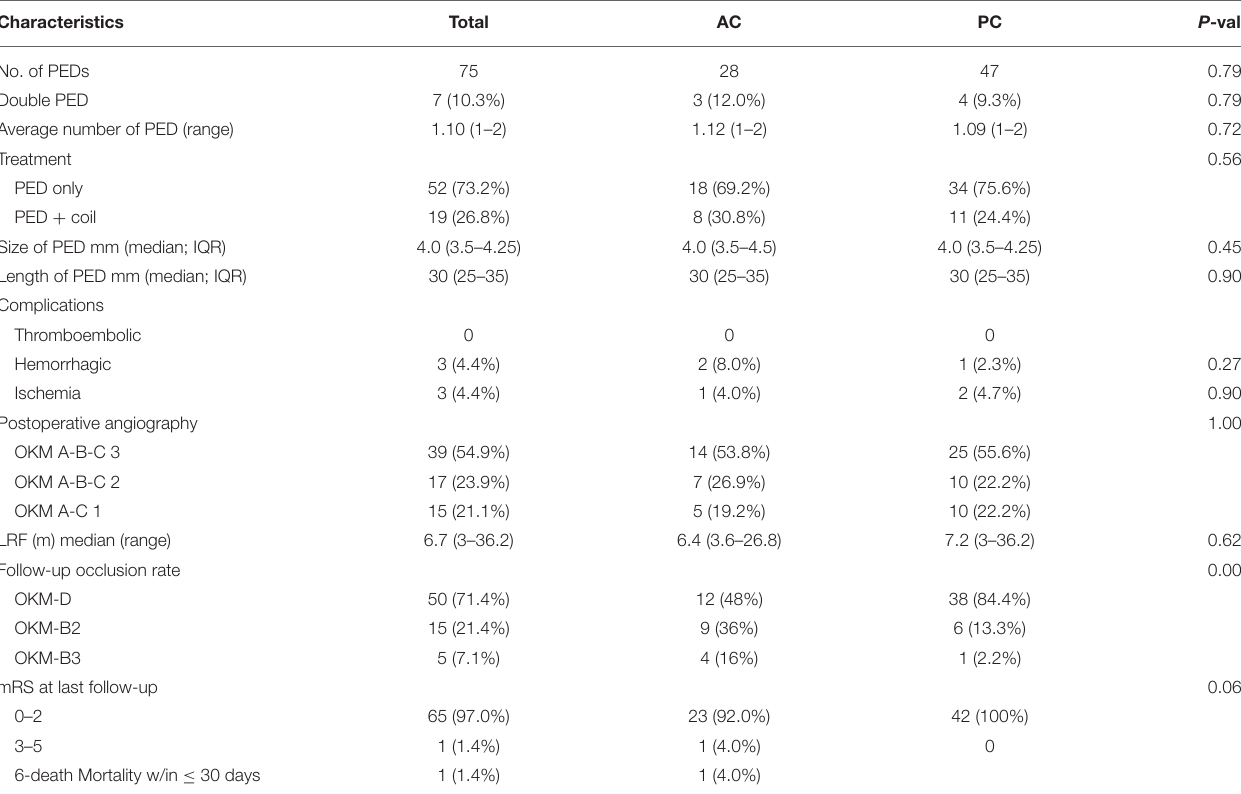
TABLE 3 | Outcome measures of 67 patients with 71 fusiform aneurysms.